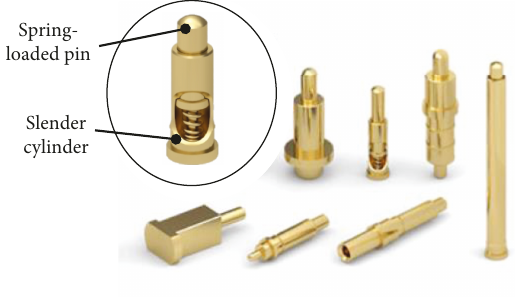
Figure 1: Example of a spring-loaded pogo pin